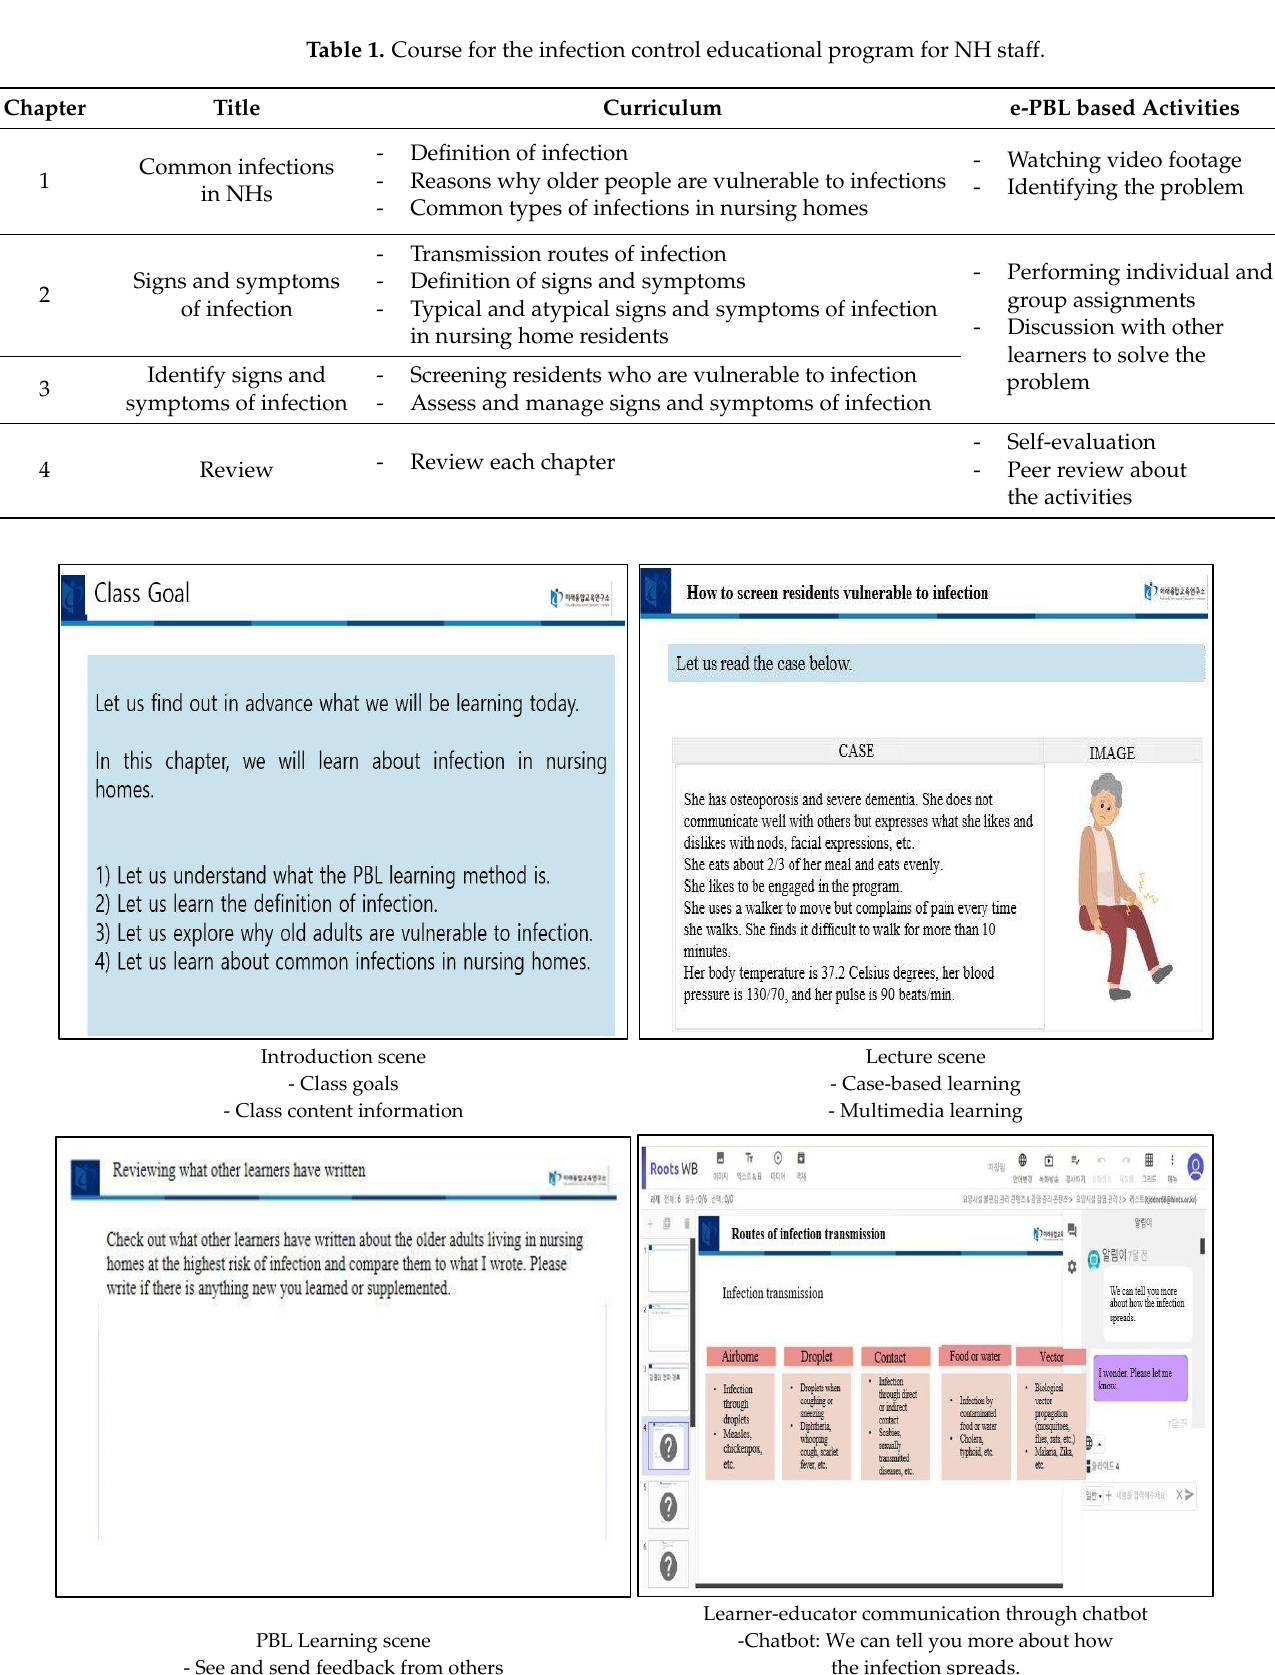
Figure 3. Example slides of the e-PBL educational program.